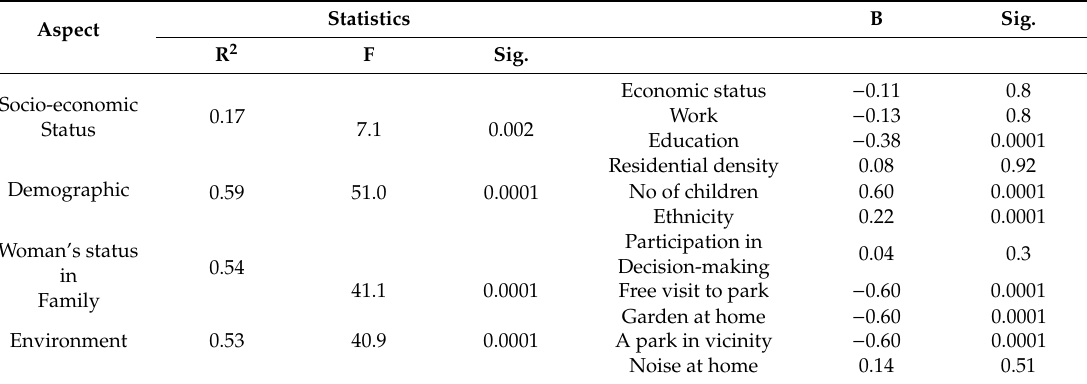
Table 3. Multiple regression analyses including possible associated stressors as related to maternal stress